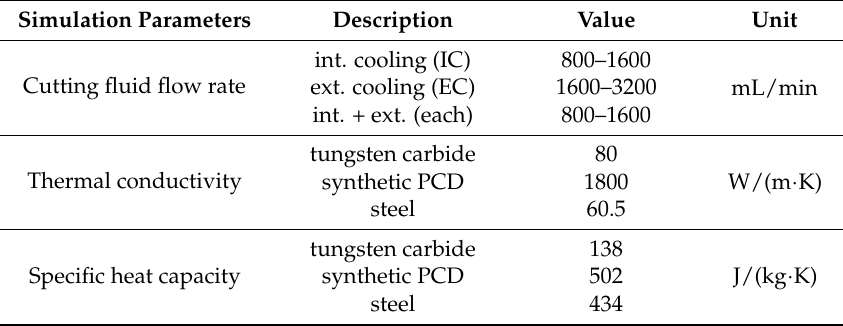
Figure 2. Simulation setup for various cooling strategies. Table 2. Simulation parameters.